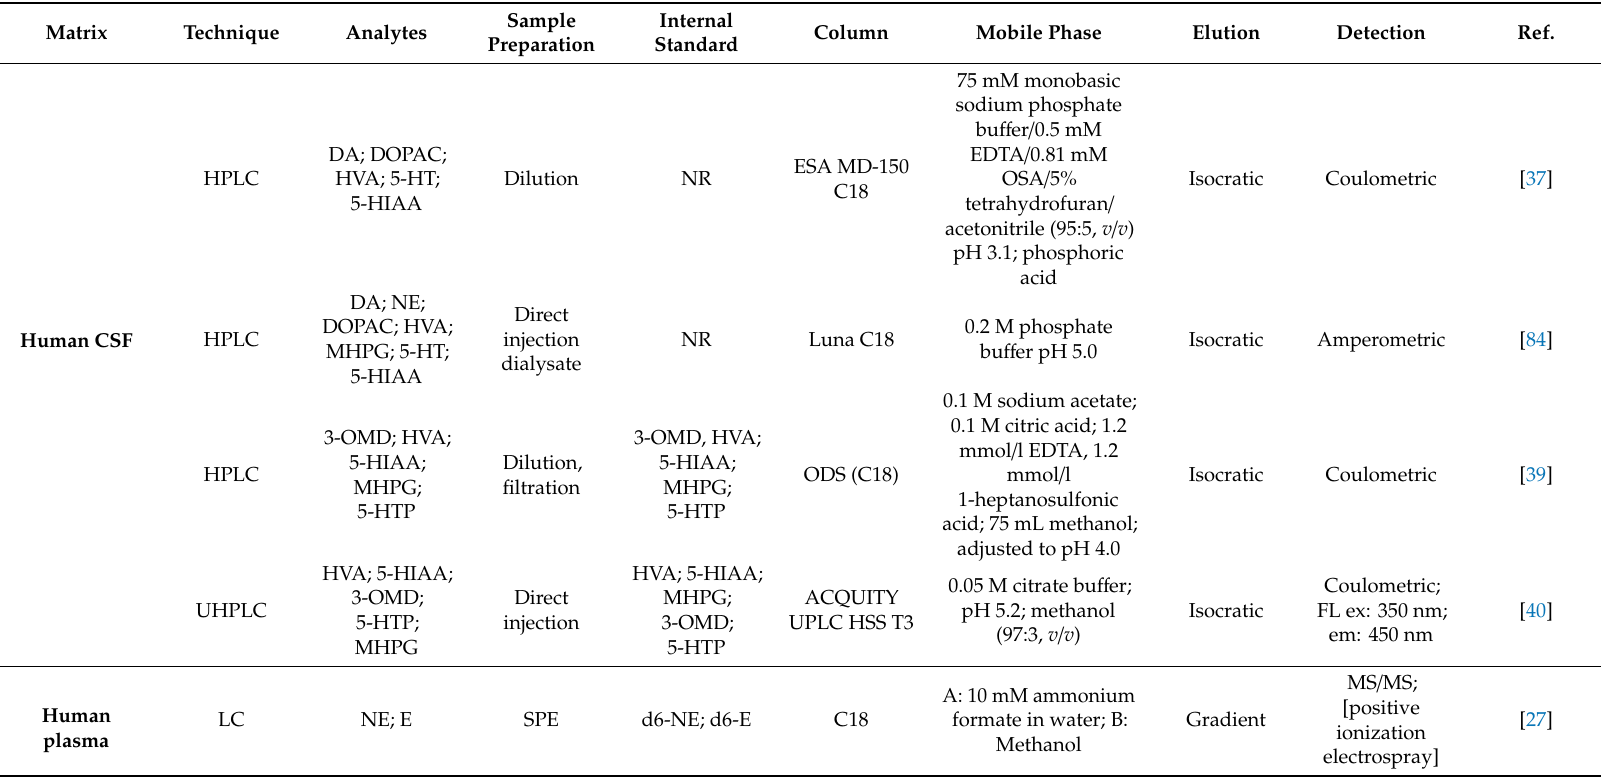
Table 2. Liquid chromatography techniques for the quantitative measurement of catecholamines and some of their metabolites in di ff erent human